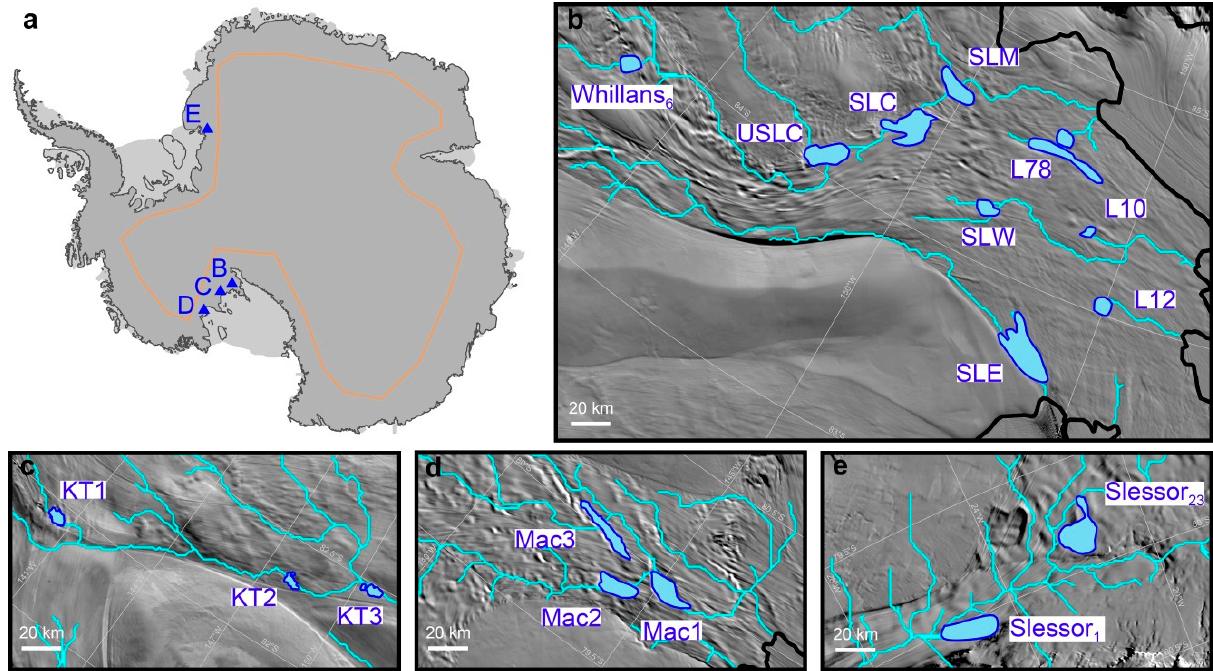
Figure 1. Maps of the subglacial lakes beneath the Mercer and Whillans Ice Streams ( b ), Kamb Ice Stream ( c ), MacAyeal Ice Stream ( d ), and the Slessor Glacier ( e ). The blue regions are the locations of the subglacial lakes; the cyan lines are simulated subglacial water pathways; the black lines are the grounding lines [27]; the base map is from Mosaic of Antarctica (MOA) image [28]. These study areas are marked in corresponding B, C, D, and E on the map of Antarctica ( a ). The mask boundary between the CryoSat-2 LRM and SARIn modes is shown in orange.